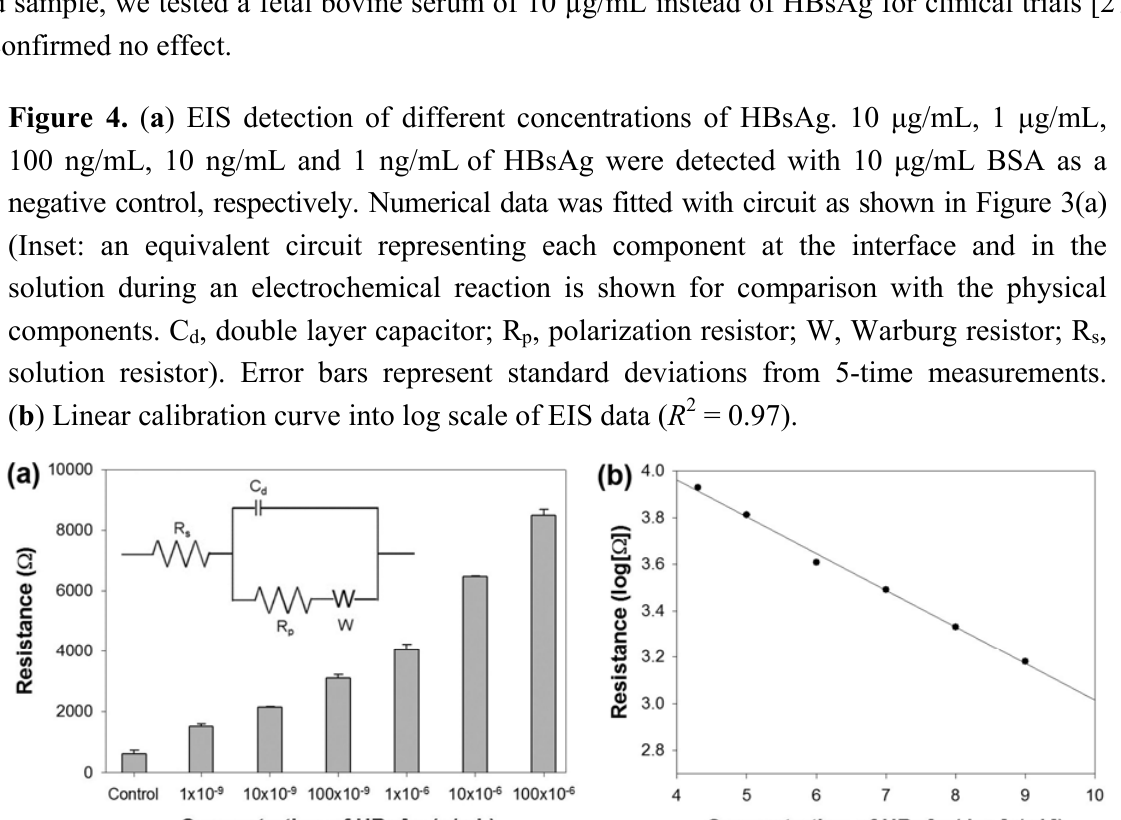
Figure 4. ( a ) EIS detection of different concentrations of HBsAg. 10 μ g/mL, 1 μ g/mL, 100 ng/mL, 10 ng/mL and 1 ng/mL of HBsAg were detected with 10 μ g/mL BSA as